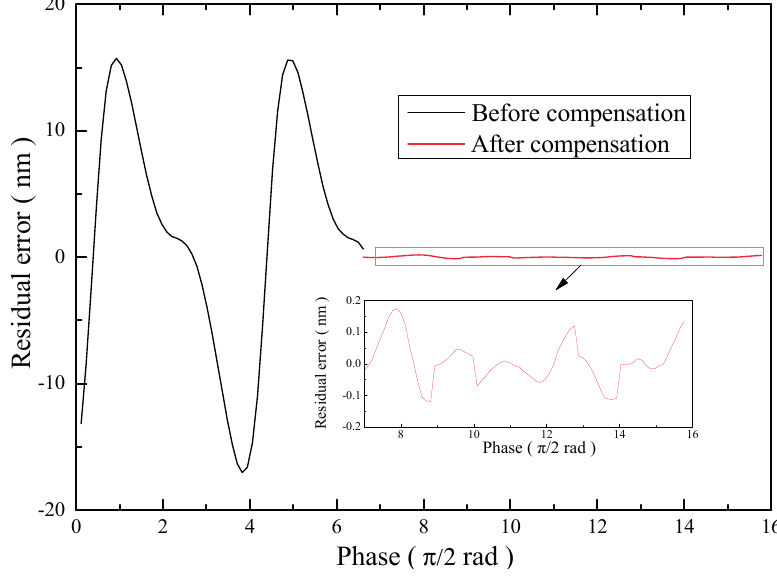
Figure 10. Cyclic errors before and with compensation using the proposed